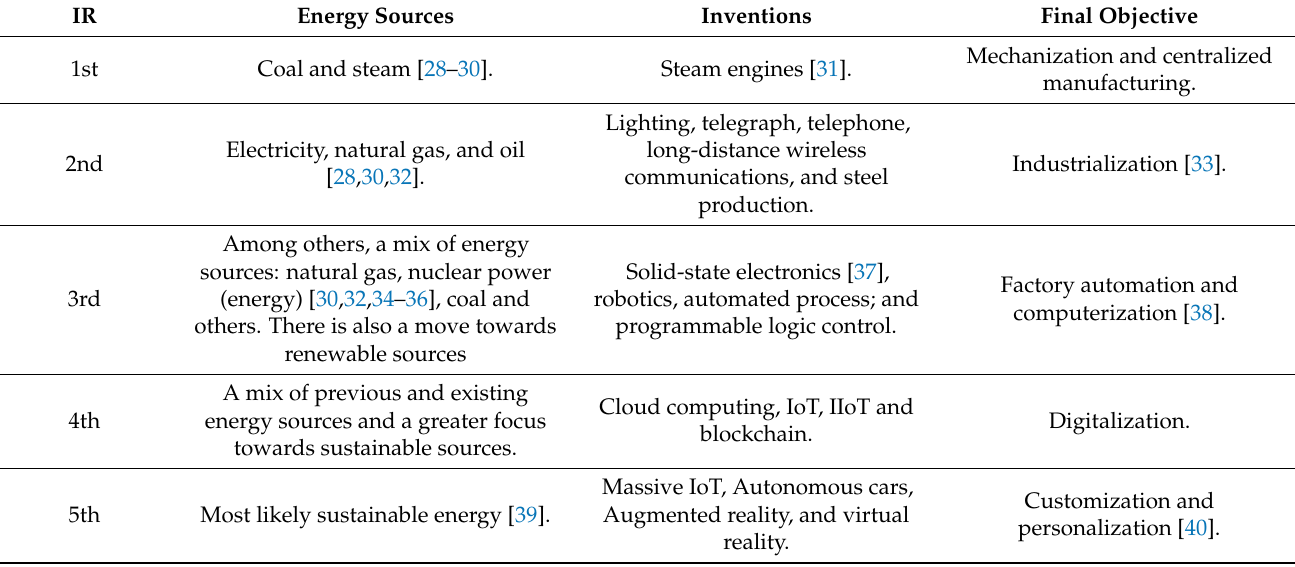
Table 1. Stages of IR, energy sources, inventions, and final objective.